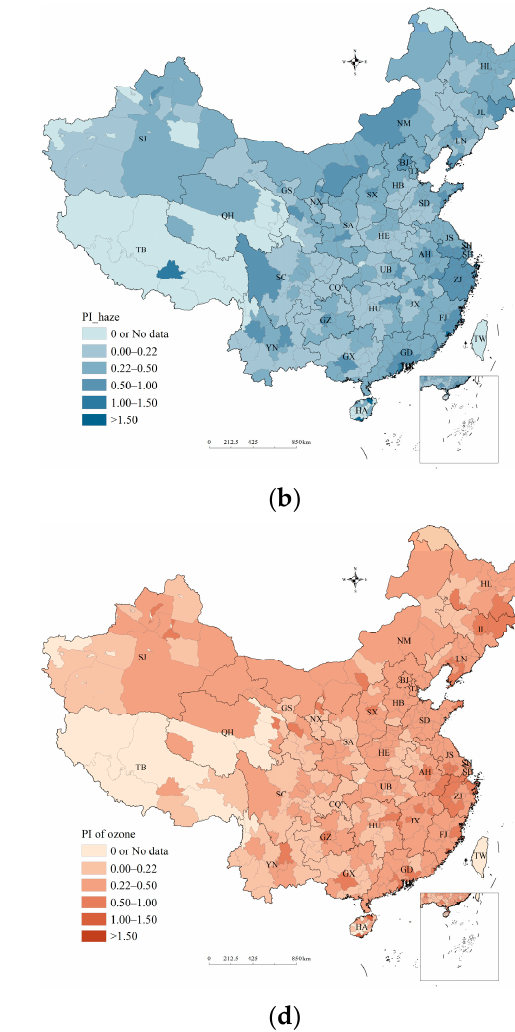
( b ) Figure 3. Air quality and PI in China: ( a ) proportion of polluted days; ( b ) PI. Table 3. Classification principles based on urban air quality and PI. Quadrant